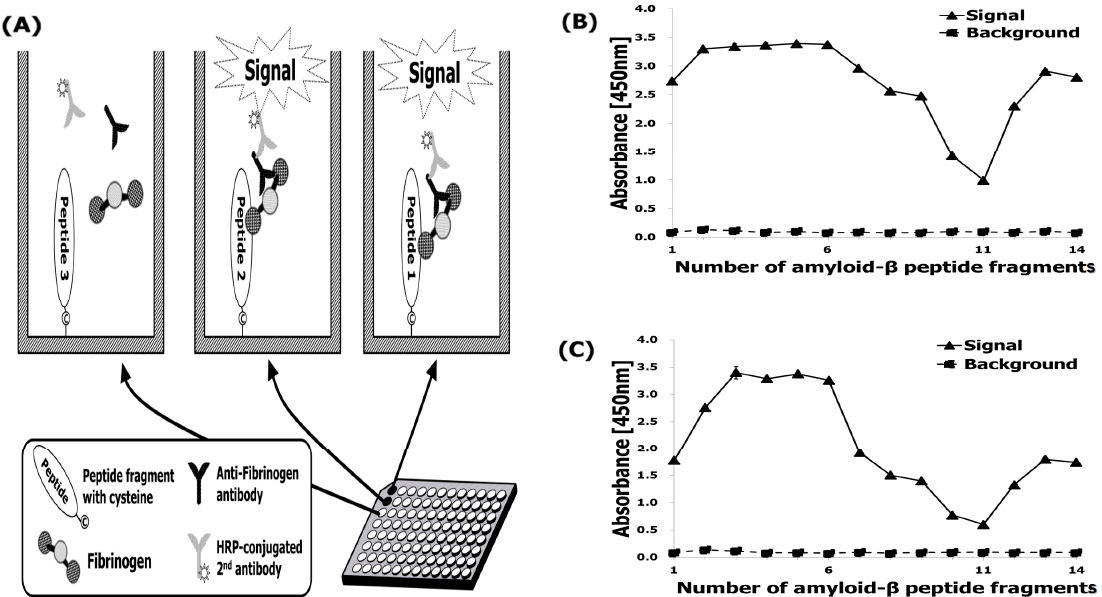
Figure 4. A β 42 epitope-mapping ELISA to find a specific site interacting with Fbg. ( A ) A β 42 epitope mapping to detect the site of interaction with Fbg. When Fbg bound to a specific sequence in A β 42, the corresponding peptide- Fbg complex was detected by anti- Fbg antibody. ( B ) Fbg attached to the A β 42 fragments detected by the pAb. ( C ) Fbg attached to the A β 42 fragments detected by the mAb. Straight line: 100 μ L of 20 μ g/mL Fbg incubated with the antibody for 2 h at 25 °C before the Fbg detection step; dotted line: 100 μ L of buffer incubated with the antibody for 2 h at 25 °C before the Fbg detection step. The straight line indicates non-specific binding of anti-Fbg antibodies.